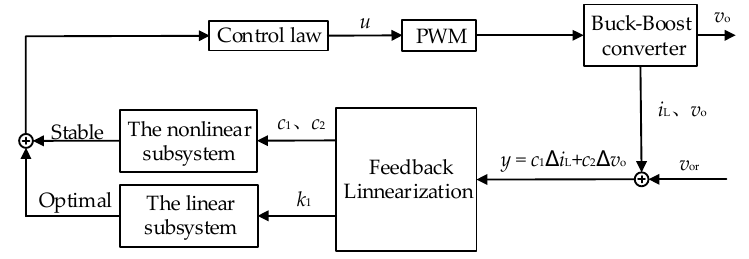
Figure 4. Closed-loop control of the buck-boost converter.